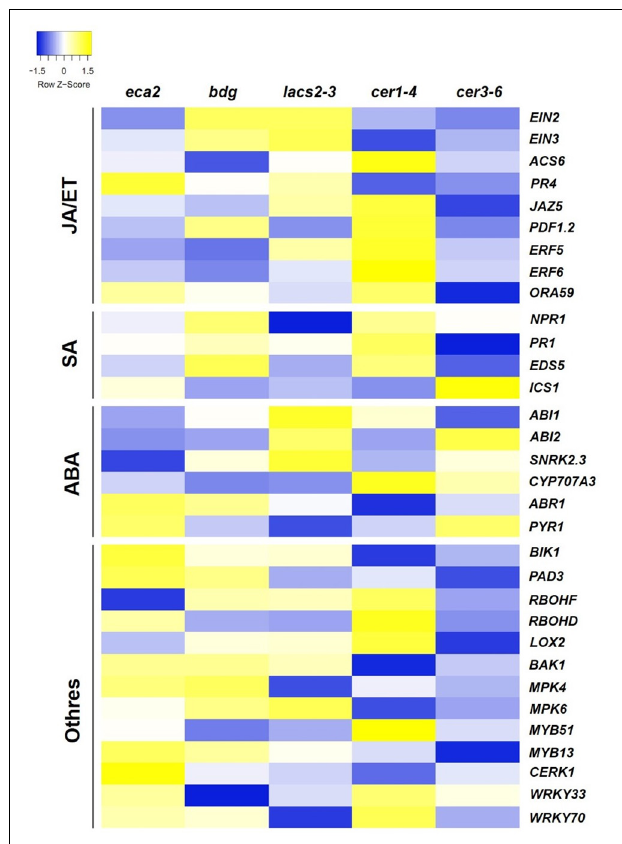
FIGURE 7 | Expression pattern of the jasmonic acid (JA)/ethylene (ET), salicylic acid (SA), and abscisic acid (ABA) signaling pathways and other defense-related genes in response to B. cinerea (6 hpi). The colors of the heat map represent the z -score of each gene expression calculated between the expression of the mutant compared with its corresponding WT, ranging from blue (–1.5) to yellow (1.5).